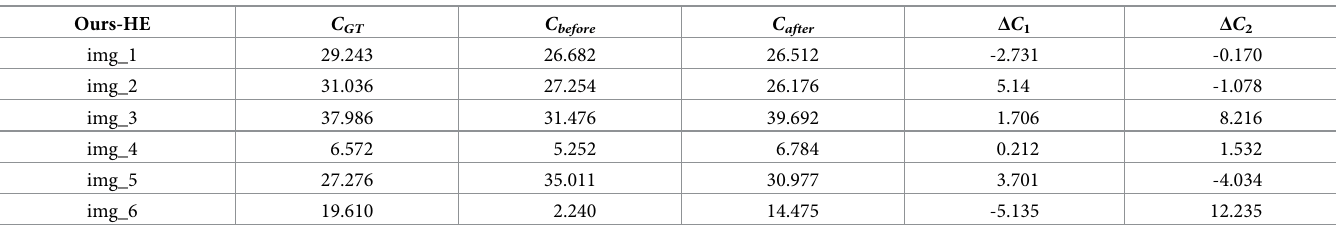
Table 4. The influence of HE on the colorfulness of ours.